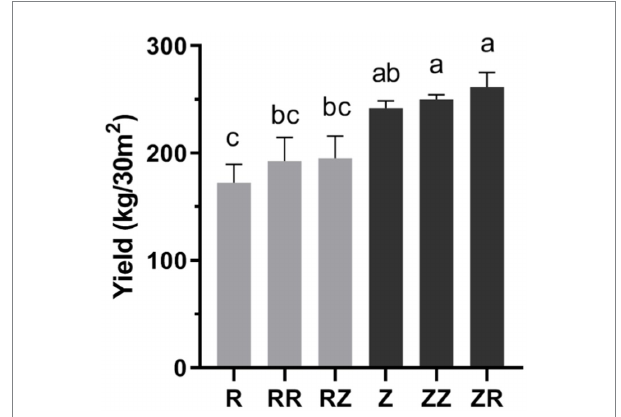
FIGURE 1 Response of sugarcane straw returning on the yield of different sugarcane cultivars. R: cultivar ROC22, RR: cultivar ROC22 plus straw of ROC22; RZ: cultivar ROC22 plus straw of Zhongzhe9; Z: cultivar Zhongzhe9; ZZ: cultivar Zhongzhe9 plus straw of Zhognzhe9; ZR: cultivar Zhongzhe9 plus straw of ROC22. The same letter of data in each column means no significant difference ( p > 0.05), while different letters mean a significant difference ( p < 0.05).